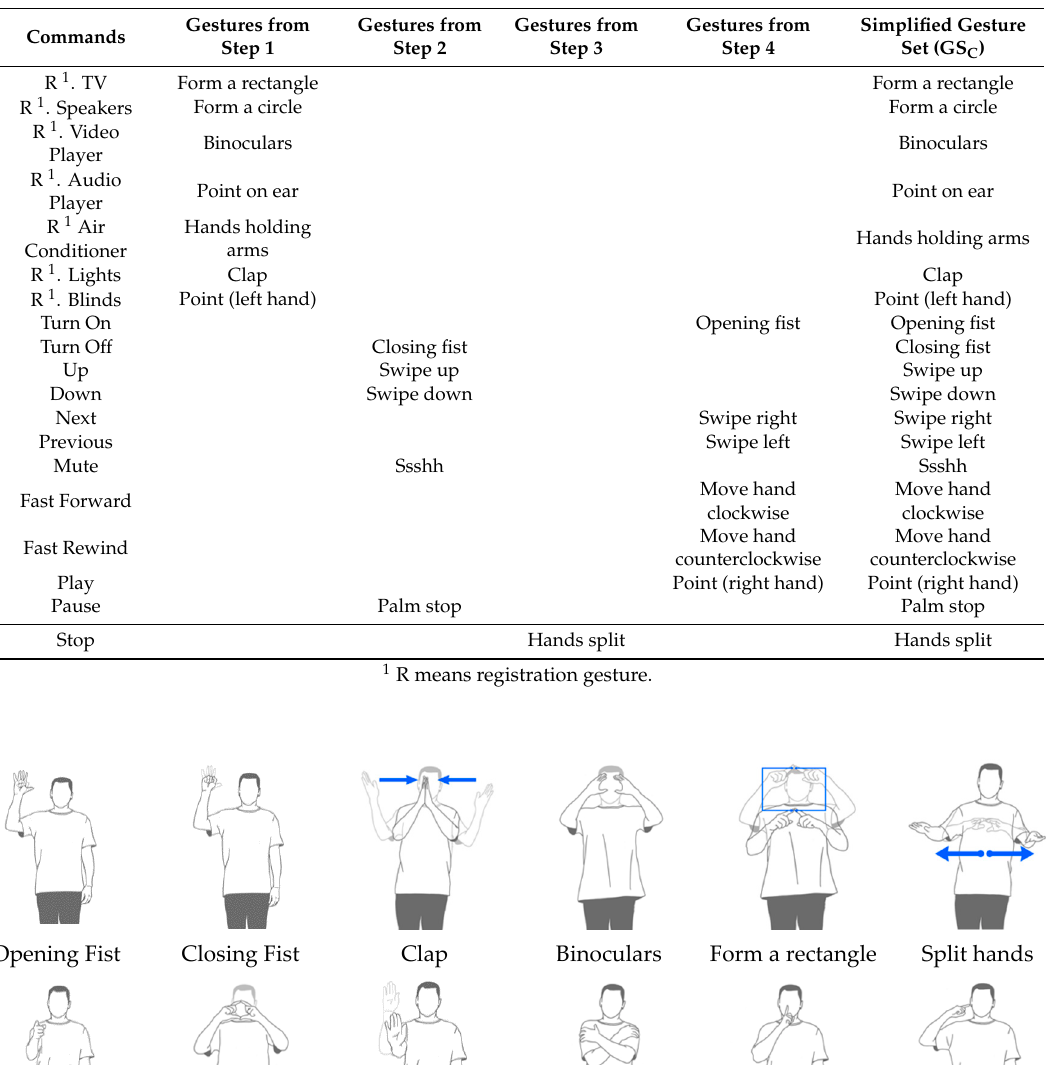
Table 1. Consistent Gesture Set (GS C ) as it is formed through the steps of “Simplification for Consistency” routine.